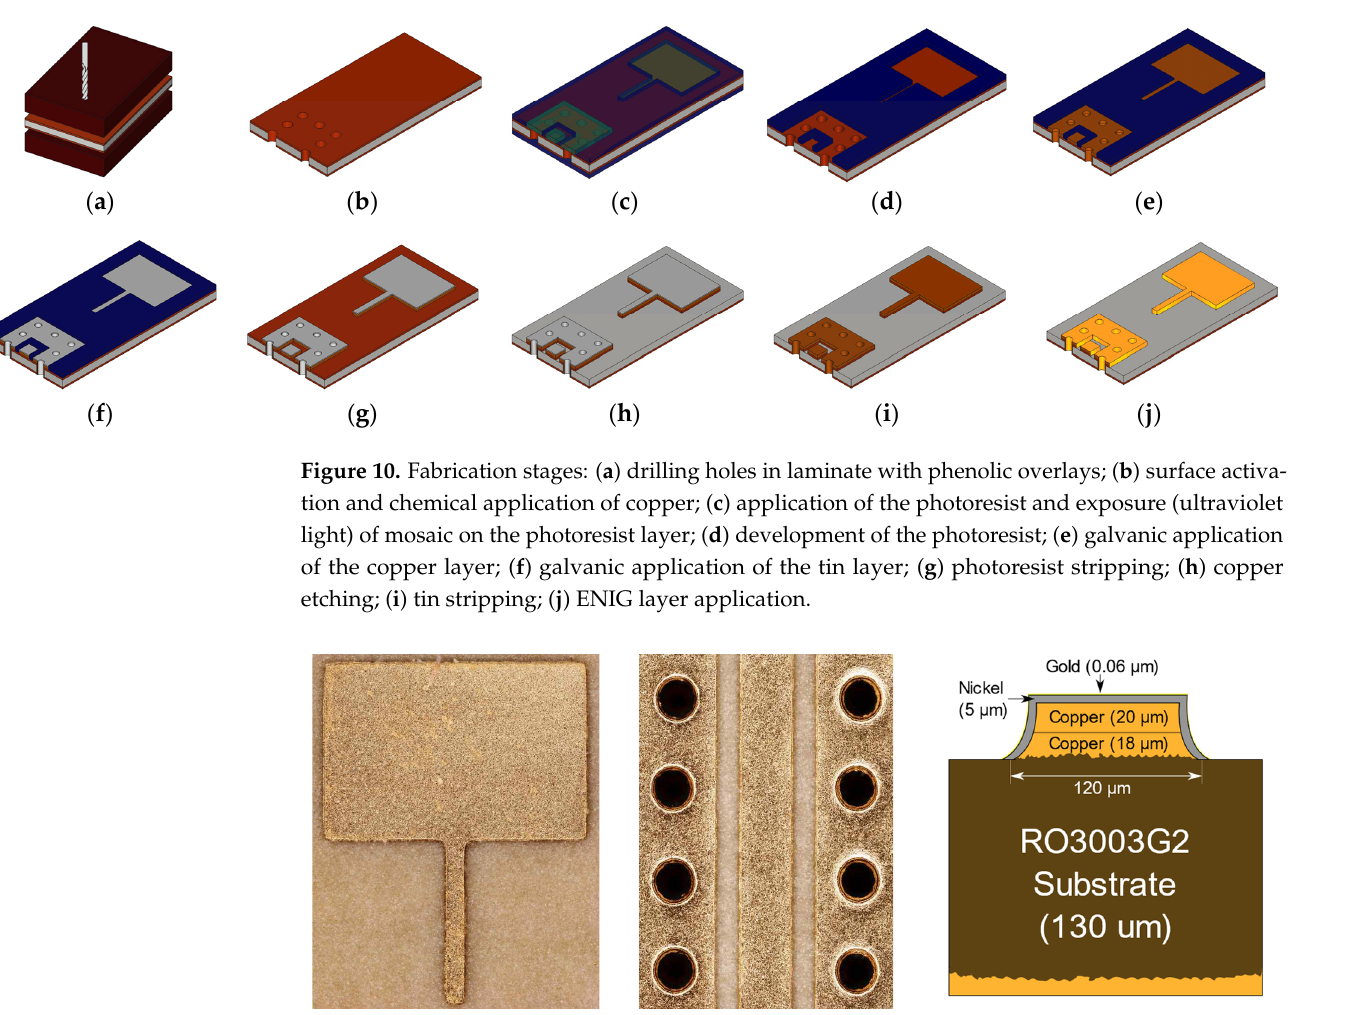
Figure 11. Fabricated structure ( a ) photograph of the patch antenna with microstrip feed line; ( b ) photograph of via holes surrounding the CPWG line; ( c ) diagram of the cross-section.